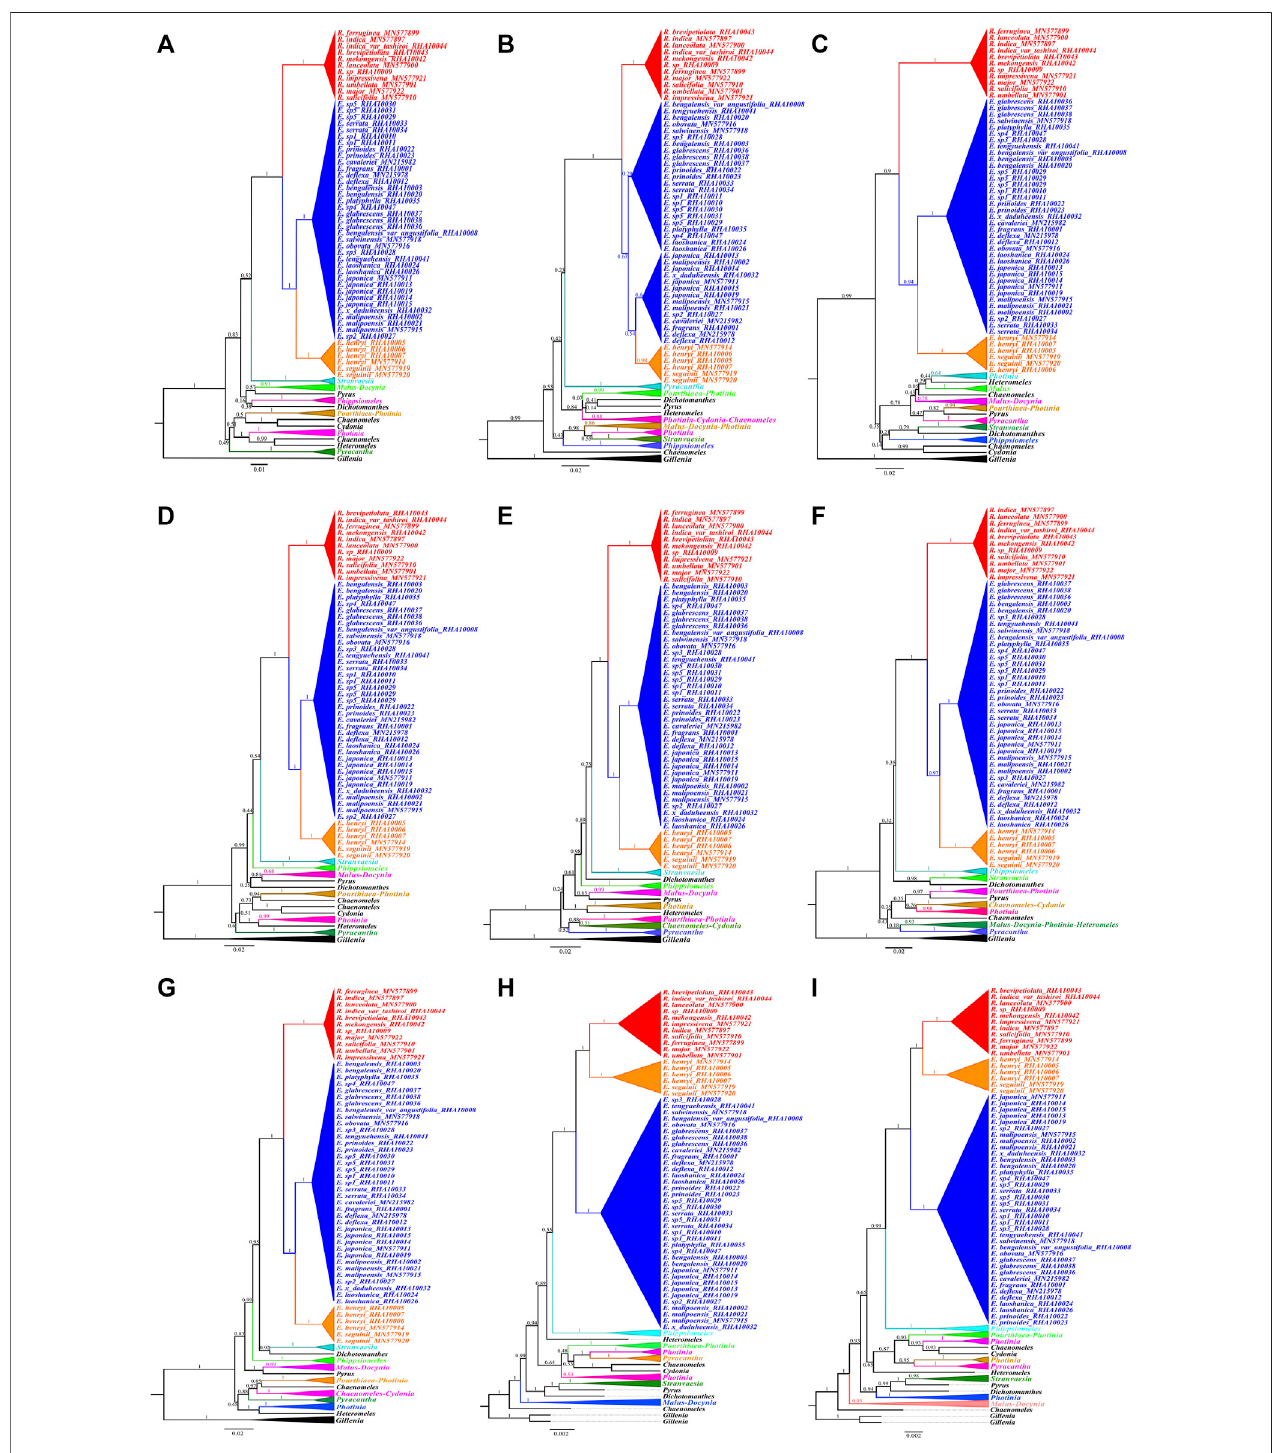
FIGURE 5 | Bayesian inference trees of all the six gene spacer sequences datasets for 97 Rosaceae individuals: ETS (A) , ITS1 (B) , ITS2 (C) , ETS-ITS1 (D) , ETS- ITS2 (E) , ITS1-ITS2 (F) , ETS-ITS1-ITS2 (G) , 18S-5.8S-26S (H) , and 26S (I) . Numbers at each node are Bayesian posterior probabilities.